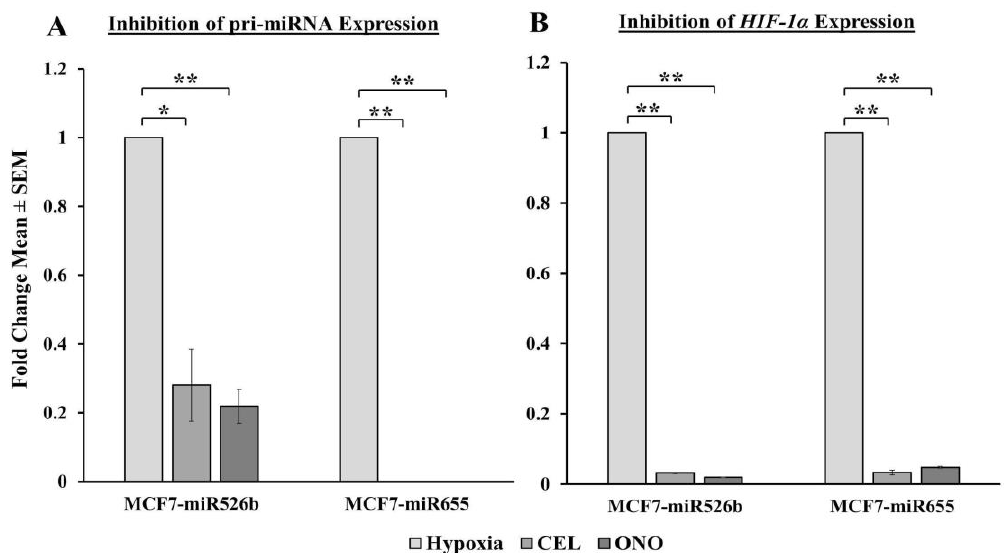
Figure 7. Pri-miR526b, pri-miR655, and HIF-1 α gene expression in hypoxia and in hypoxia with inhibition: ( A ) Inhibition of pri-miR526b and pri-miR655 gene expression in hypoxia. ( B ) Inhibition of HIF-1 α gene expression in hypoxia. Data are presented as the mean ± SEM of quadruplicate replicates; * p < 0.01 and ** p < 0.001.